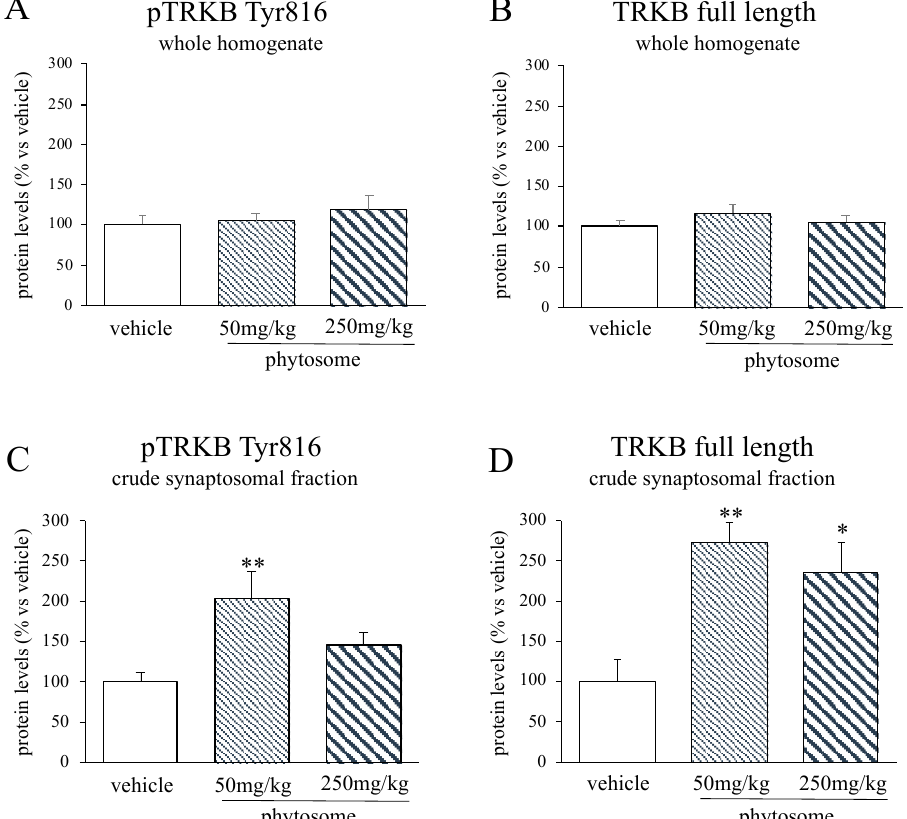
Figure 3. Analyses of pTRKB Tyr816 ( A – C ) and TRKB full length ( B – D ) protein levels in the whole homogenate ( A , B ) and crude synaptosomal fraction ( C , D ) of the PFC of rats treated with phytosome 50 mg / kg or 250 mg / kg. Data are expressed as percent change of vehicle treated rats and are represented in the histograms graphs as mean ± SEM of 4–6 independent determinations. * p < 0.05, ** p < 0.01 vs. vehicle; one-way ANOVA with Fisher’s PLSD.